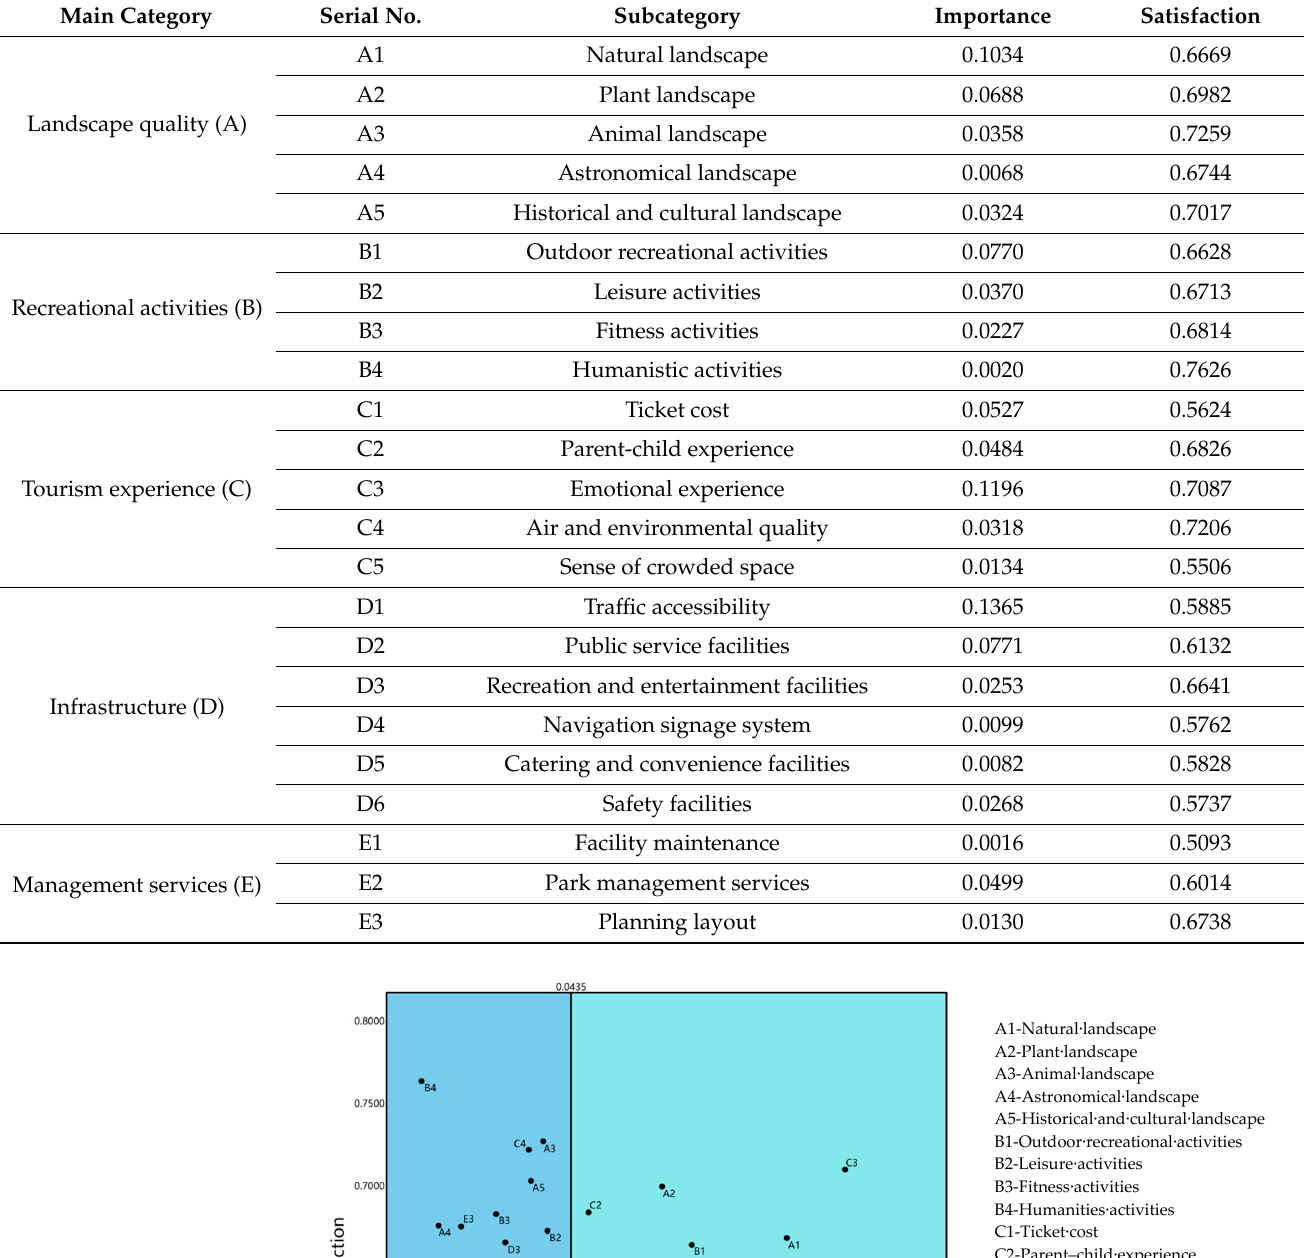
Table 9. Importance and satisfaction scores of tourists’ satisfaction in terms of recreation.